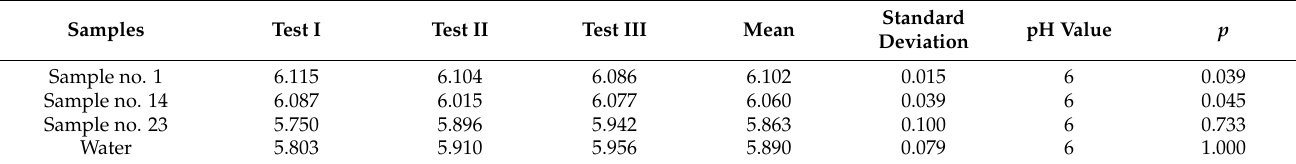
Table 12. pH values.